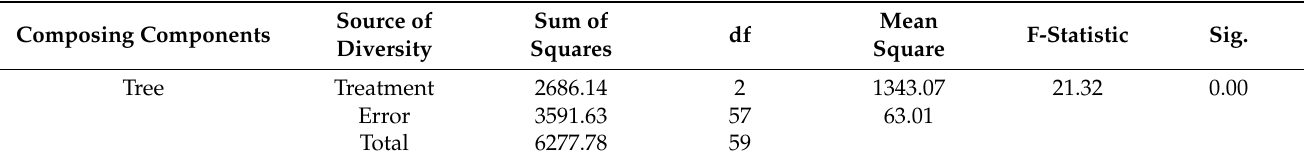
Table 7. Honest Tukey’s significant difference test results for the average amounts of C stored in D. polyphylla trees for three age classes.